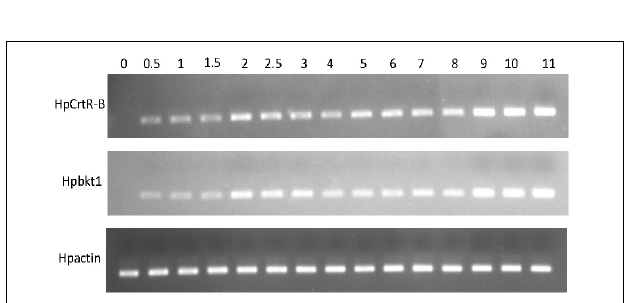
FIGURE 2 | Expression pattern of HpCrtR-B and Hpbkt1 responding to HLS